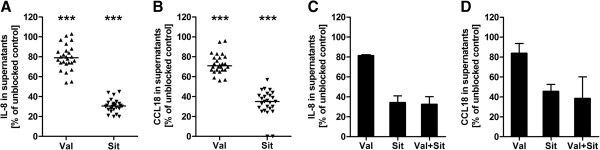
Receptor antagonists reduced interleukin 8 and chemokine (C-C motif) ligand 18 secretion, inhibiting effects are not additive. (A) Interleukin 8 (IL-8) and (B) chemokine (C-C motif) ligand 18 (CCL18) concentrations in the supernatants of peripheral blood mononuclear cells (PBMCs) from healthy donors after 8 hours of in vitro stimulation by immunoglobulin G of systemic sclerosis patients (SSc-IgG) after pretreatment with either the angiotensin II receptor type 1 blocker valsartan (Val) or the endothelin receptor type A blocker sitaxsentan (Sit), measured by enzyme-linked immunosorbent assay (ELISA) and normalized to the corresponding sample without any antagonist representing 100%. Data are derived from one experiment done with 26 SSc-IgG. Simultaneous blocking with both antagonists did not improve the inhibiting effects: (C) IL-8 and (D) CCL18 concentrations in the supernatants of PBMCs from three healthy donors after 8 hours of in vitro stimulation by SSc-IgG after pretreatment with valsartan (Val) or sitaxsentan (Sit) or both (Val + Sit) measured by ELISA and normalized to the corresponding samples without any antagonist representing 100%. Data derived from three independent experiments done with pooled IgG from thirteen SSc patients. Statistical analysis was done by Wilcoxon matched-pairs test. Medians (A and B) and medians with range (C and D) are shown. ***P < 0.001.